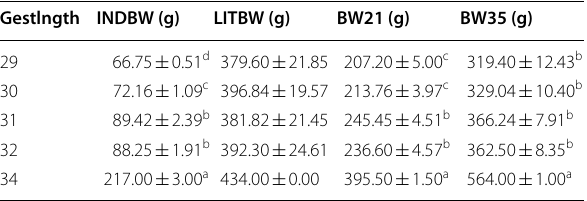
Table 3 Effect of gestation length on least-squares means of body weights of crossbred